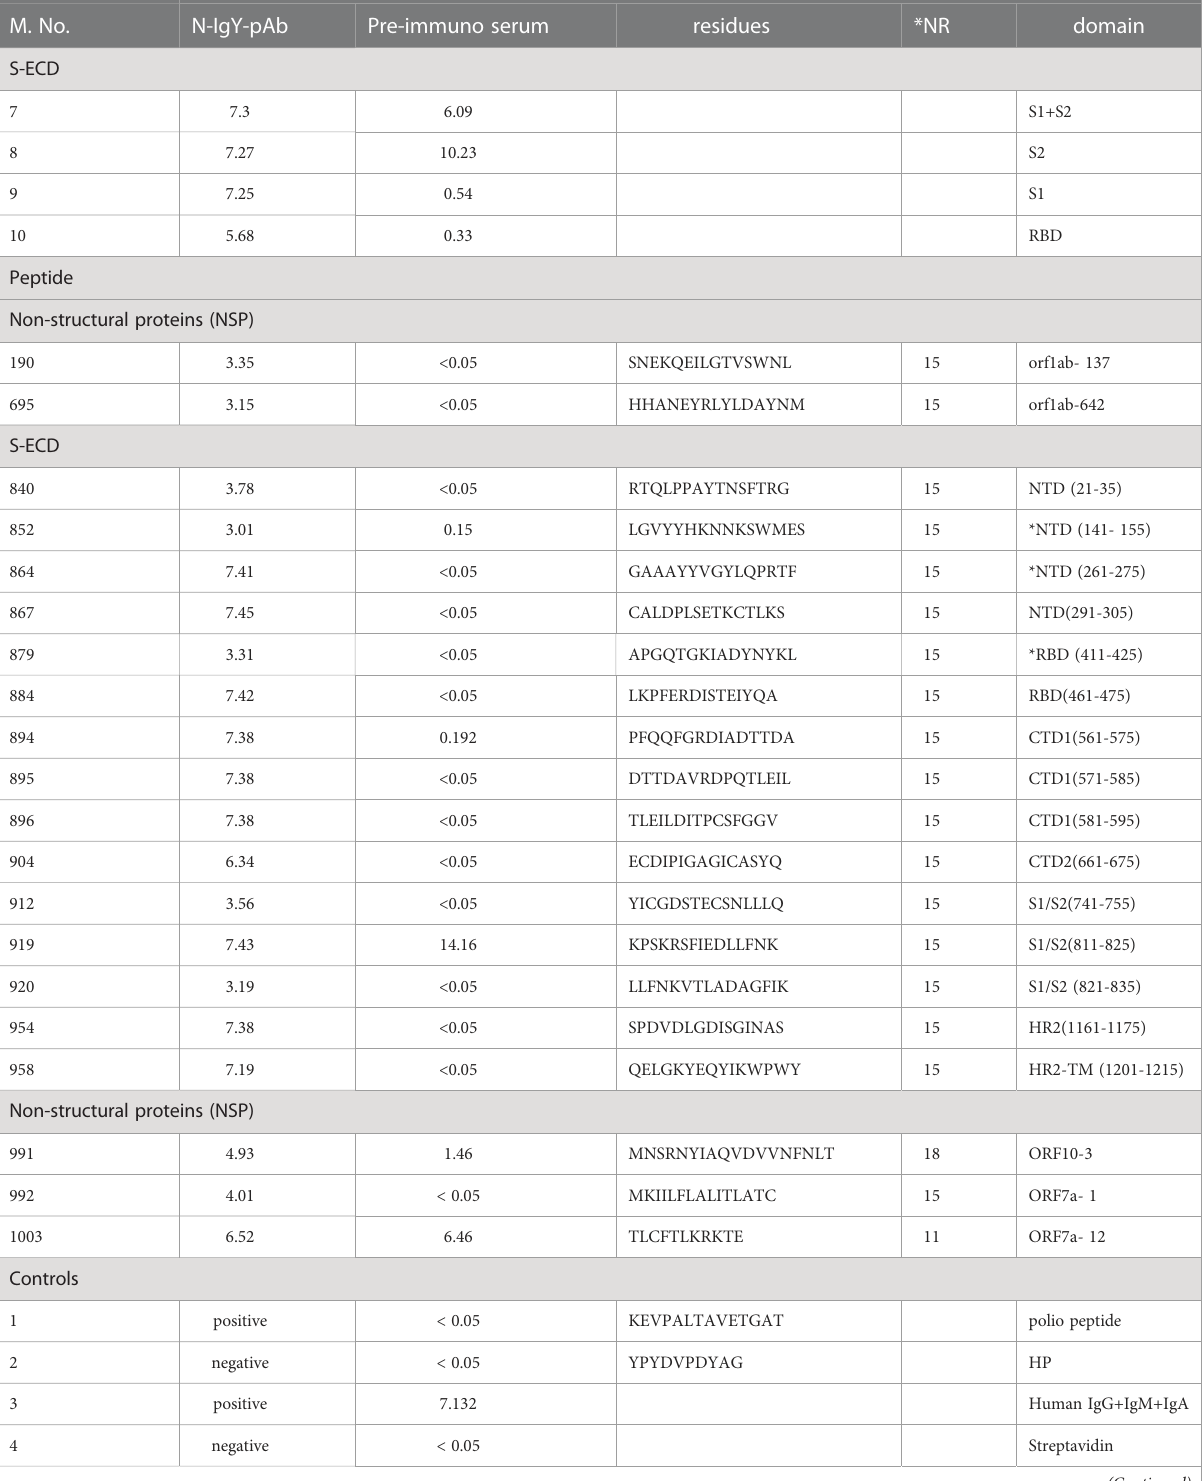
TABLE 1 Binding sizes of N-IgY-pAb to peptides or proteins of S-ECD in SARS-CoV- 2 virus. Sample No Z-score ≥